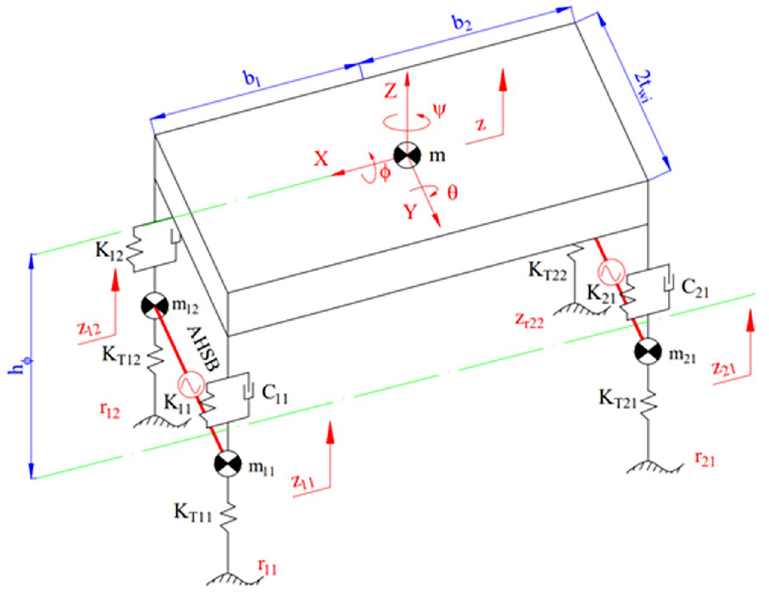
Fig 1. Model of the spatial